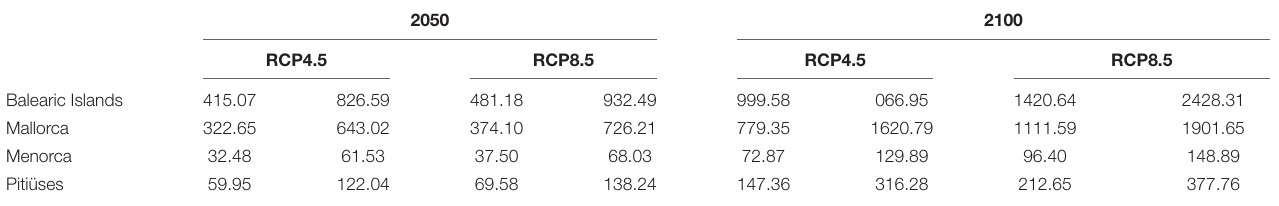
TABLE 3 | Loss of beach recreational services in monetary value (millions of euros) under RCP4.5 and RCP8.5 climate change scenarios for 2050 and